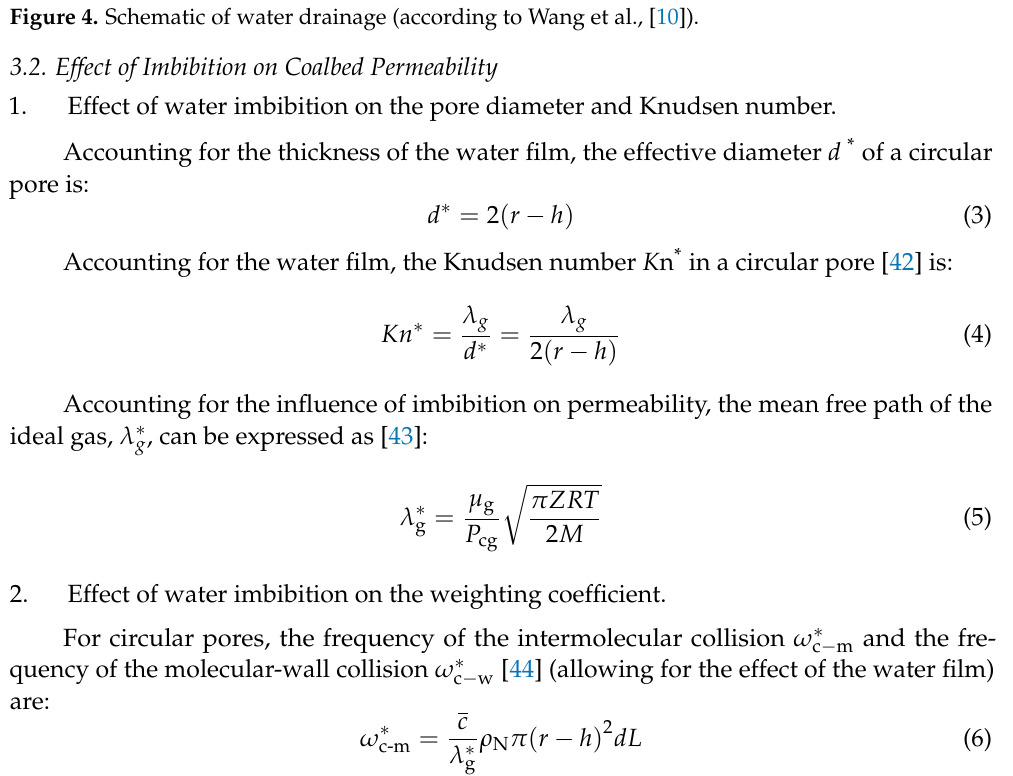
Figure 4. Schematic of water drainage (according to Wang et al.,